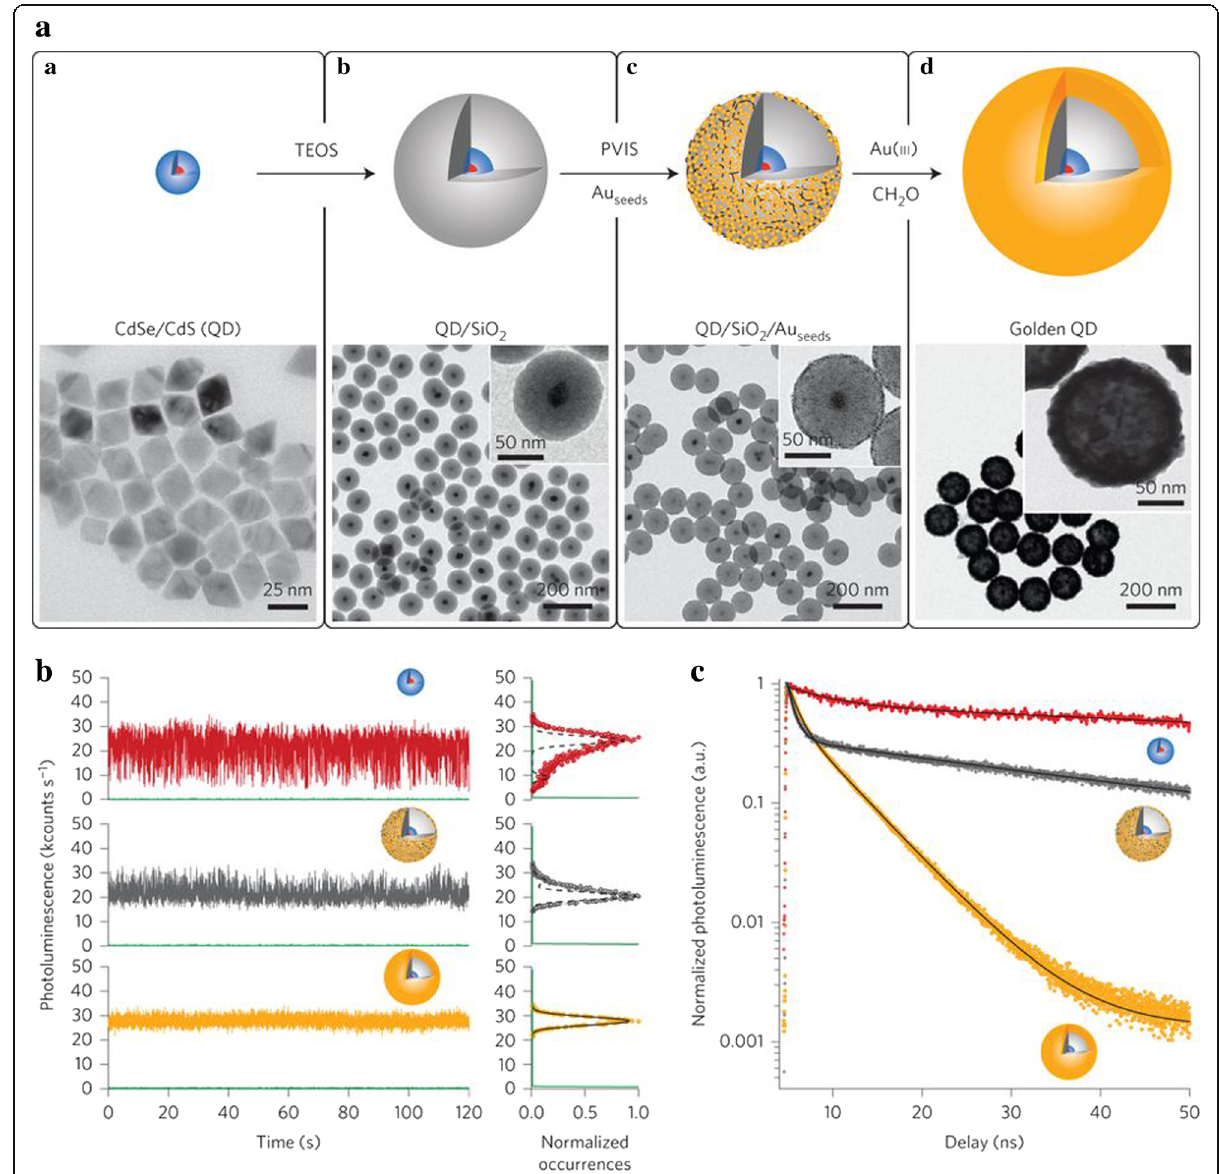
Fig. 10 a Schematic of quantum dot/SiO 2 /Au hybrid (golden QD) and the TEM images of each stages (CdSe/CdS QDs, QD/SiO 2 QD/SiO 2 /Au seed and golden QDs). b The change of photoluminescence intensity with time. Red for CdSe/CdS, gray for QD/SiO 2 /Au seed , and orange for golden QDs. c Photoluminescence decay curves of three nanoparticles in ( b )